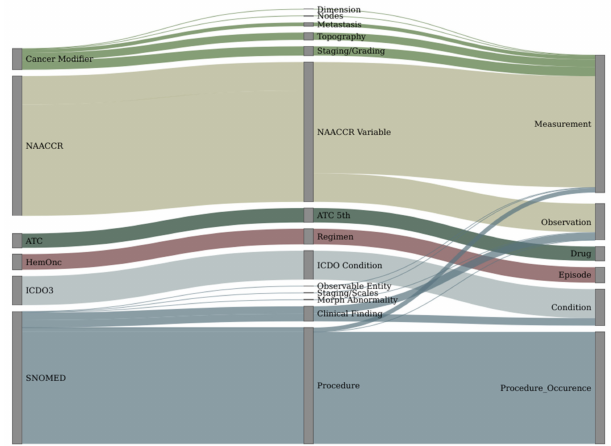
Figure 2. Sankey Diagram showing a flowchart of mapped vocabulary dependent on their concept class and